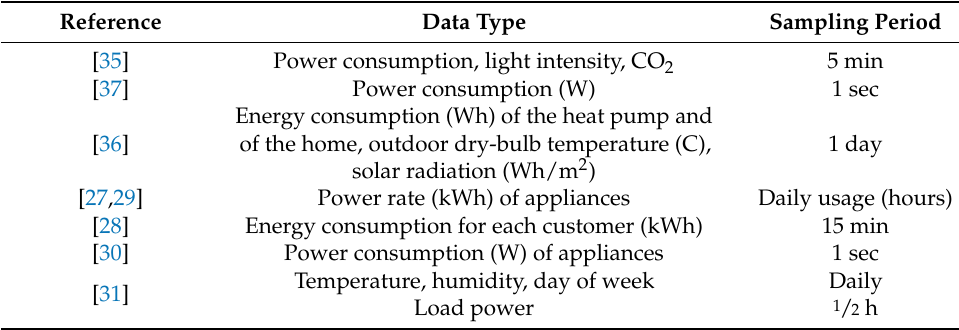
Table 1. Data types for load-demand scheduling.